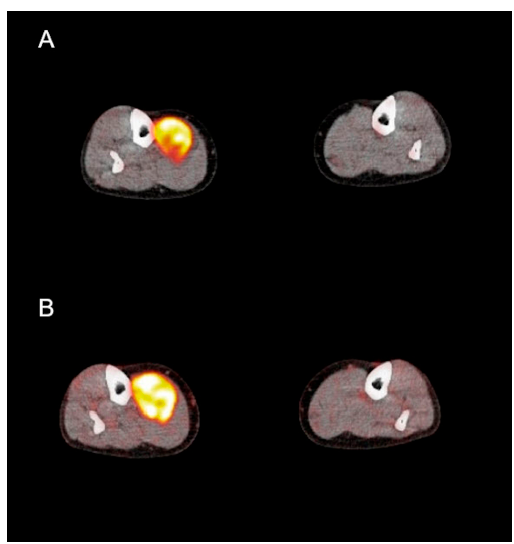
Figure 4. Transaxial fludeoxyglucose F-18 positron emission tomography/computed tomography ( 18 F-FDG PET/CT) of a 70-year old female patient with sarcoma of the leg before ( A ) and after pazopanib therapy ( B ). Persistent metabolic activity in the tumor after pazopanib treatment.